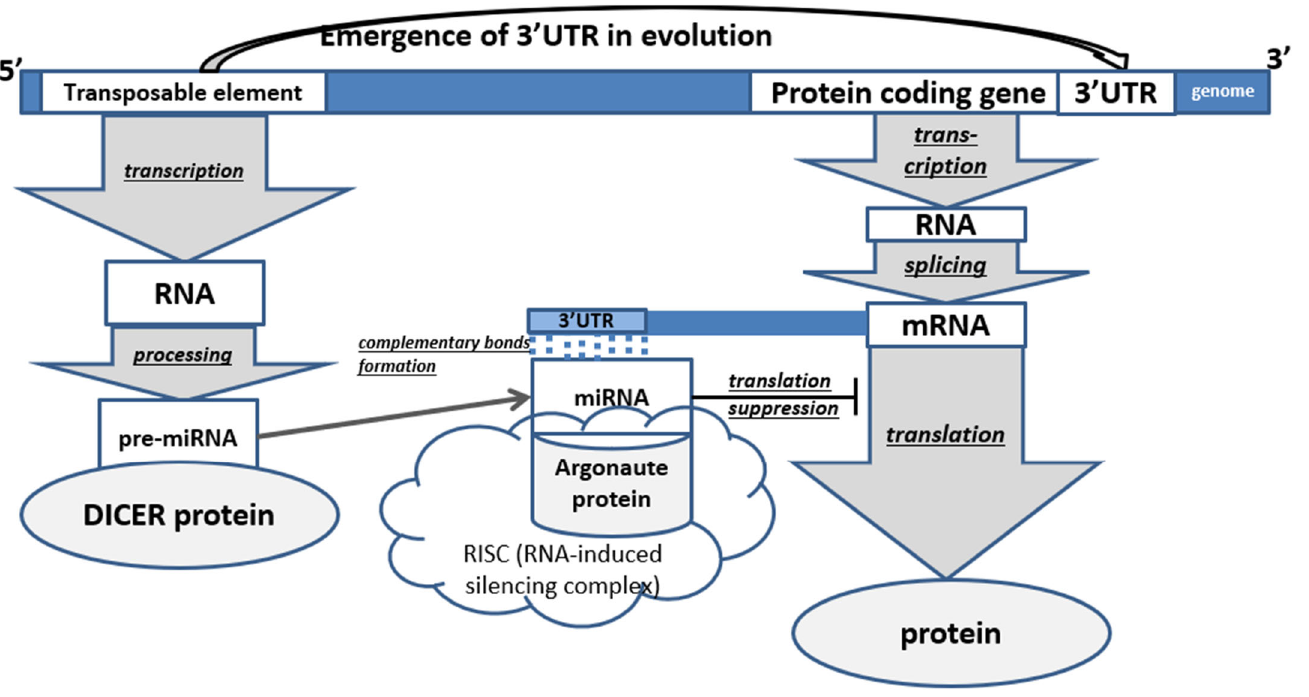
Figure 2. Scheme of the role of transposable elements in post-transcriptional regulation of protein-coding genes in animals (PCG—protein-coding gene). The underlined words in the figure represent processes.